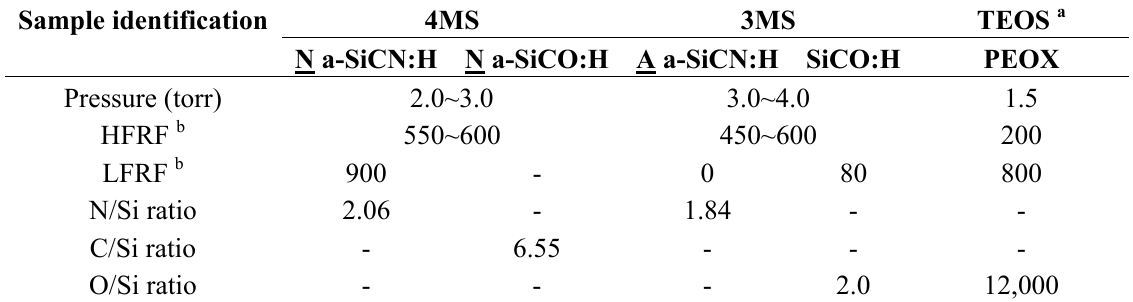
Table 1. Deposition condition of trimethylsilane (3MS) or tetramethylsilane (4MS)-base films. Sample identification